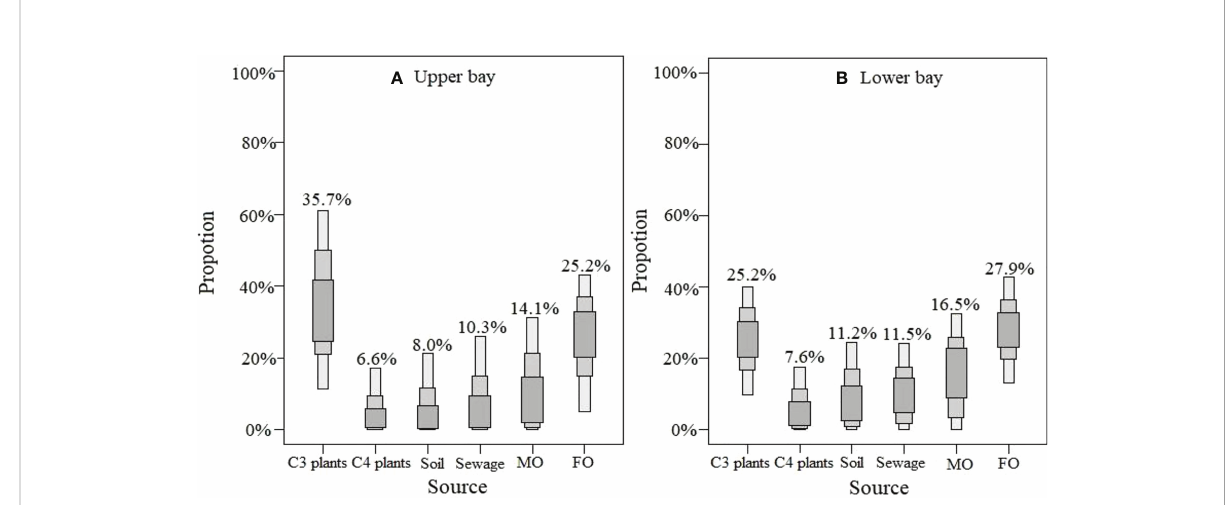
FIGURE 7 Source apportionment of the POM sources in the upper bay (A) and lower bay (B ; soil represents terrestrial soil organic matter, MO represents marine organic matter, and FP represents freshwater phytoplankton ) . The dark boxes indicate the median values, and the light-colored boxes at the top and bottom indicate the maximum and minimum